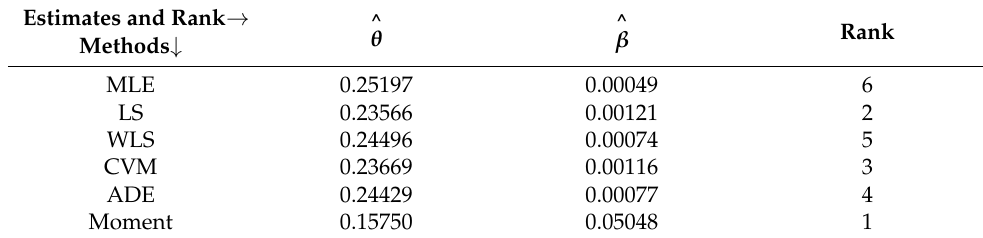
Table 8. The estimators and ranks for the C model under insurance claims data for all estimation